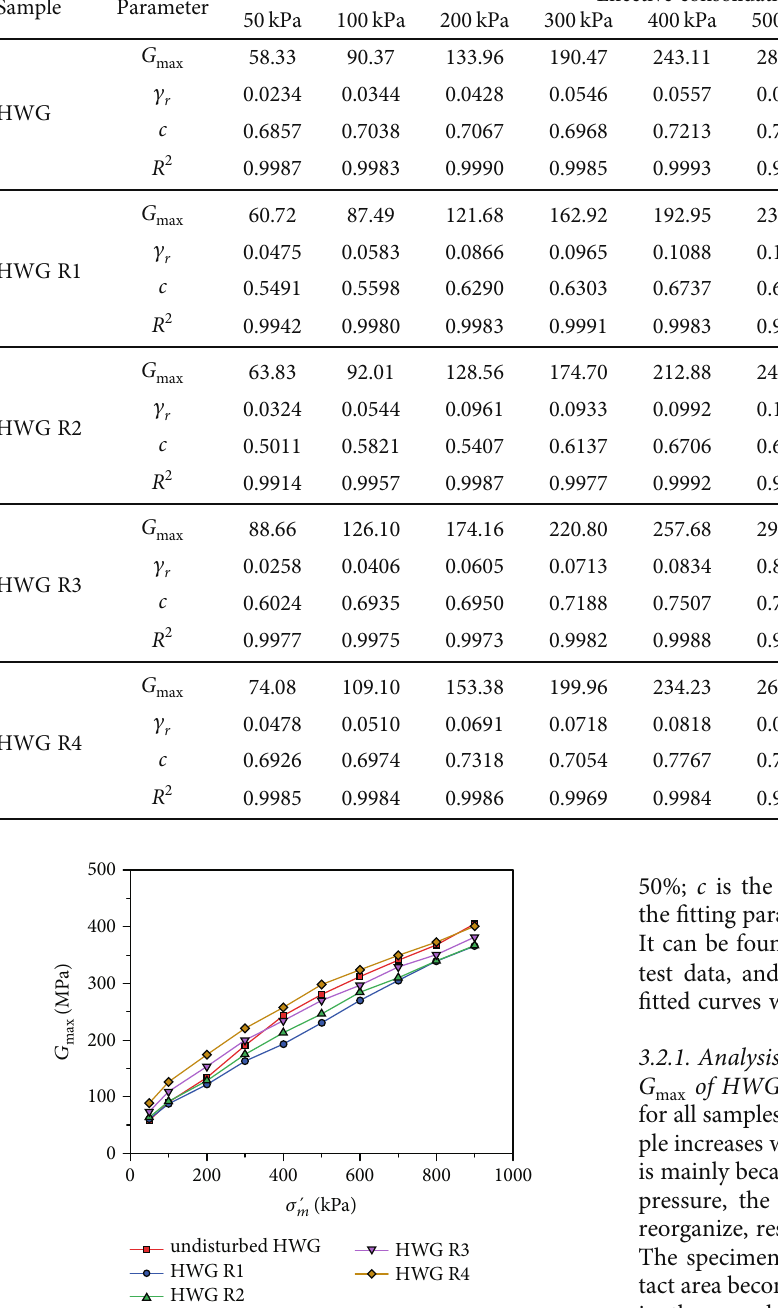
Figure 6: Relationship between G